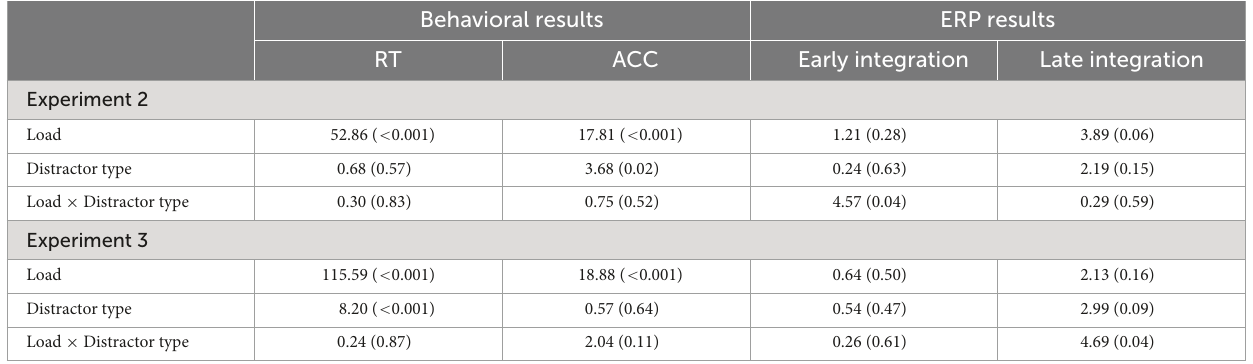
TABLE 1 Results of the ANOVA in Experiments 2 and